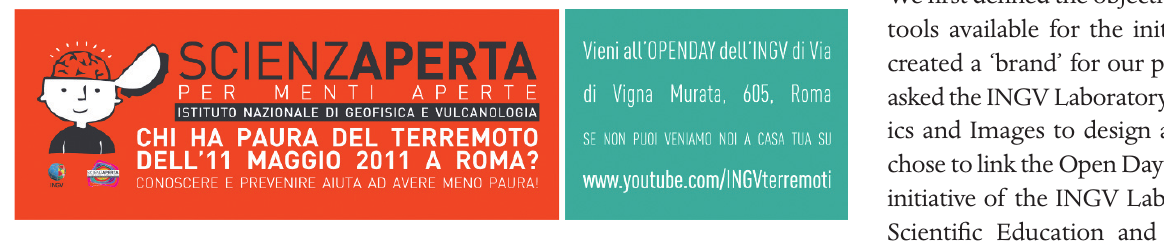
Figure 1. Invitations to the Open Day at INGV, showing the ‘brand’ of the event.